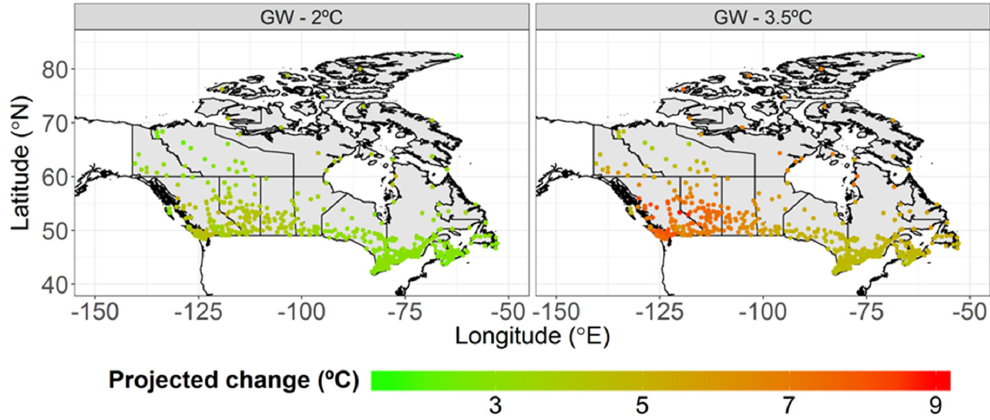
Figure 6. Projected changes in July 2.5% design temperatures (dry) in Canada under globally averaged warming of 2 °C and 3.5°.